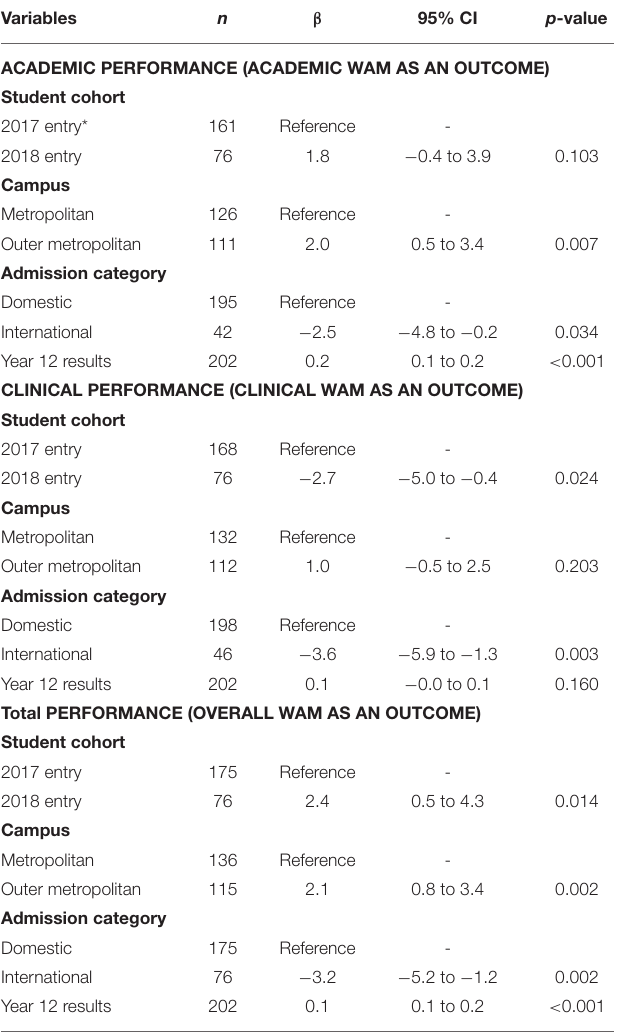
TABLE 4 | Predictors of academic, clinical and overall performances assessed using multivariable linear regression